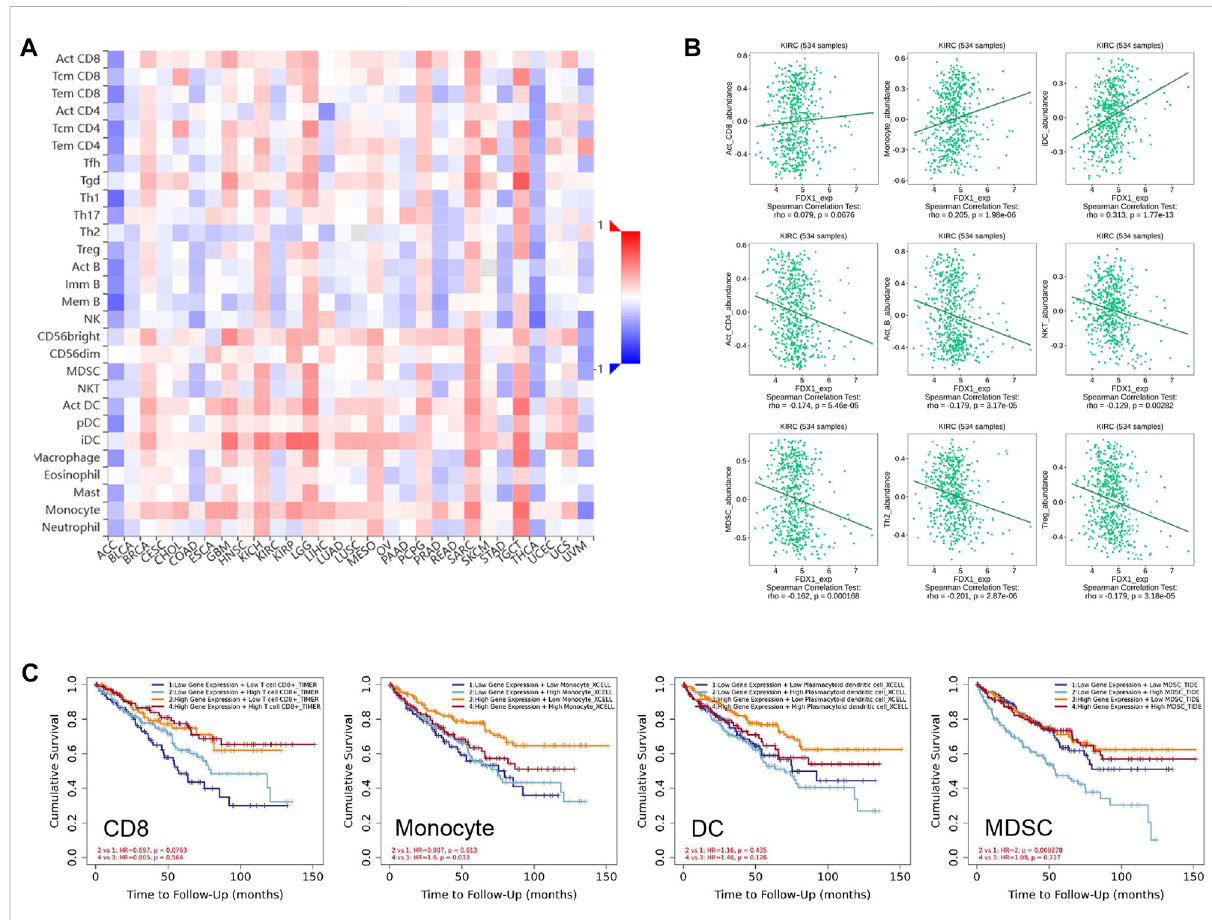
FIGURE 8 Relationship between FDX1 expression and the abundance of tumour-in fi ltrating lymphocytes. (A) Heatmaps demonstrating the positive (red colour) or negative (blue colour) correlation between FDX1 and the in fi ltration level of indicated immune cells across human cancers. The shade of colour in the heatmap represents the size of rho values. (B) Correlation of FDX1 expression and tumour-in fi ltrating lymphocytes like activated CD4, activatedCD8,activatedB,monocytes,dendriticcells,naturalkillerT,type1 Thelper,type2